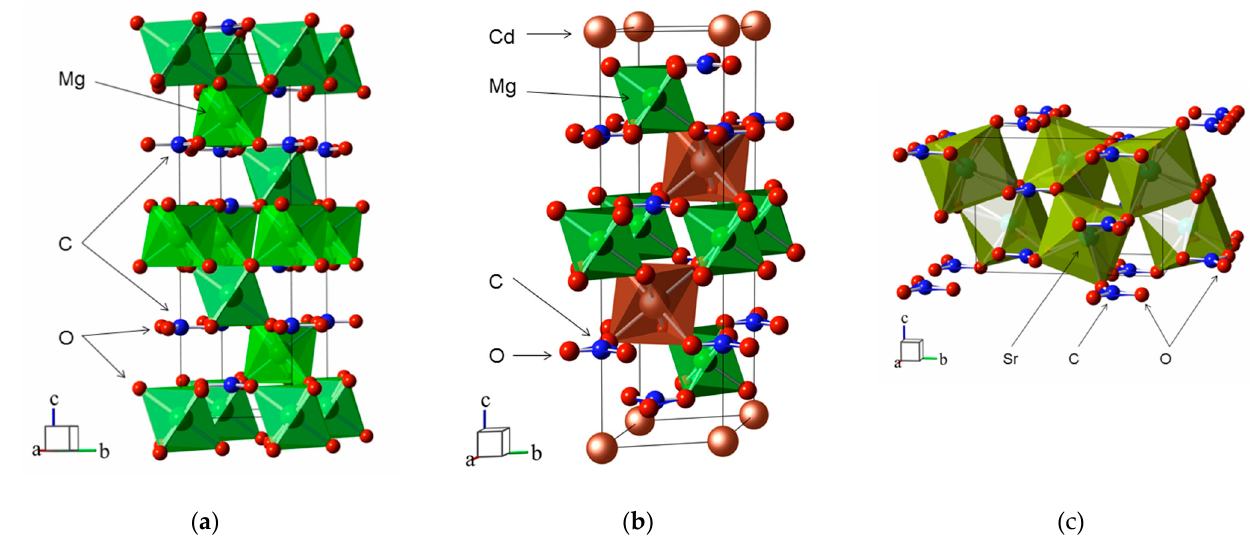
Figure 1. Crystal structures of ( a ) MgCO 3 (calcite), ( b ) CdMg(CO 3 ) 2 (dolomite) and ( c ) SrCO 3 (aragonite). The unit cells are outlined. Lone atoms, except for those in the unit cells, are omitted for clarity.